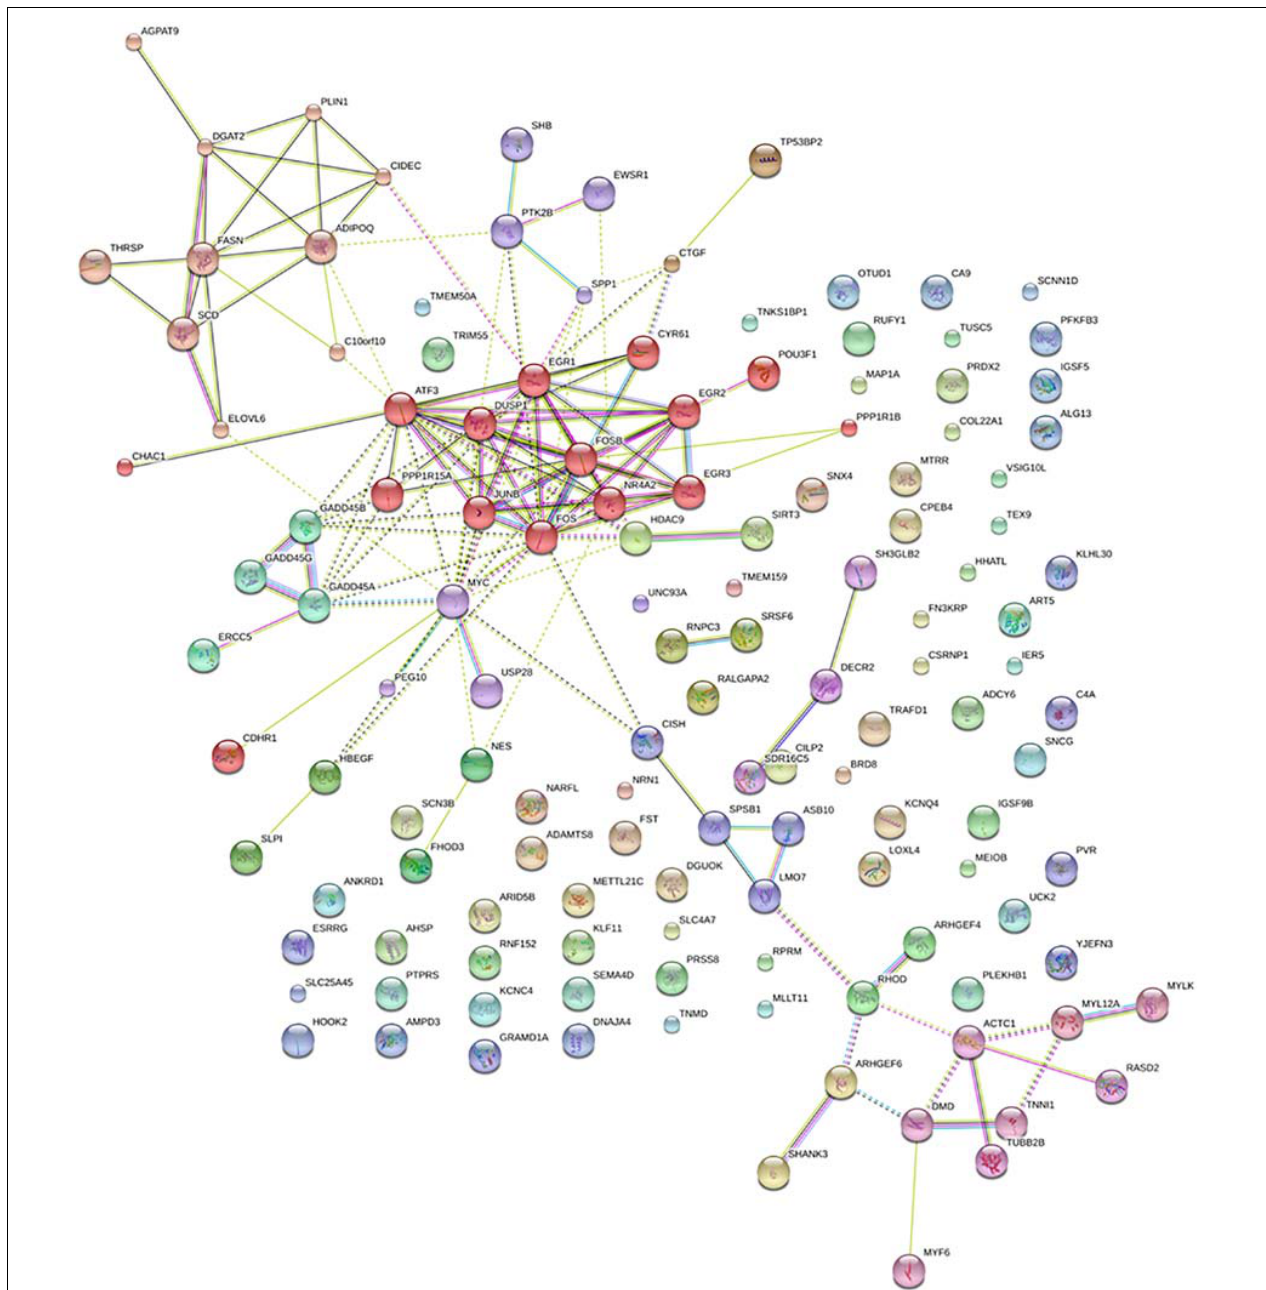
FIGURE 2 | Network of protein–protein interactions predicted with STRING database. Same color nodes sharing multiple edges are grouped in the same cluster.